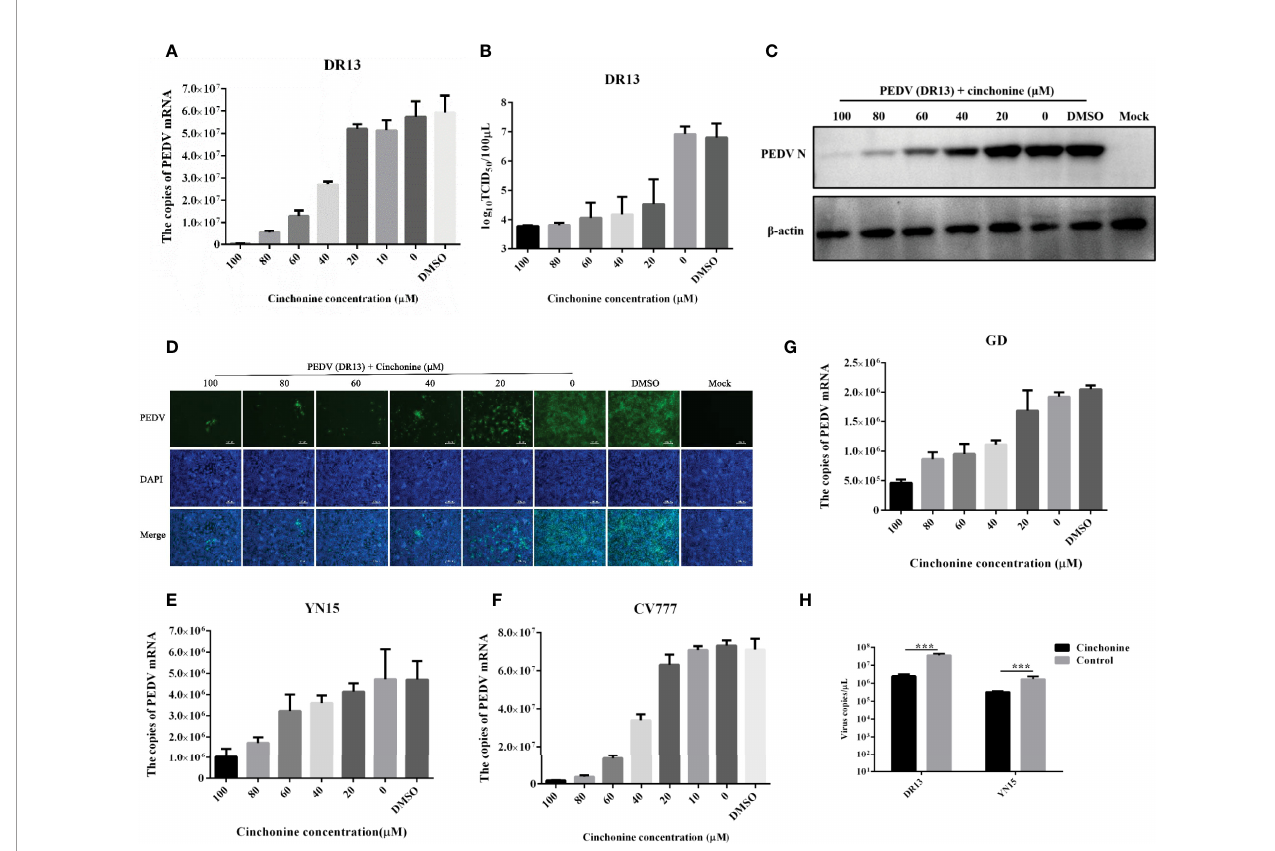
FIGURE 2 | Detection of anti-PEDV activity of cinchonine in Vero CCL81 and LLC-PK1 cells. (A – D) Vero CCL81 cells were infected with DR13 strain in the presence of cinchonine at the various concentrations (0, 20, 40, 60, 80, 100 m M). At 24 h post-infection, the samples were prepared for the quantitative real-time RT-PCR, TCID 50 assay, Western Blot or IFA. (E – G) Vero CCL81 cells were infected with CV777, YN15 or GD strain and then treated with the different concentrations (0, 20, 40, 60, 80, 100 m M) of cinchonine for 24 h. The mRNA level of PEDV was then measured by the quantitative real-time PCR. (H) LLC-PK1 cells were infected with DR13 or YN15 strain in the presence or absence of cinchonine. The samples were collected at 24 h to assess the copies of PEDV mRNA. The results depicted shown in Figures are representative result from at least three independent experiments. The data has been shown as mean ± standard deviation (SD). *** p <